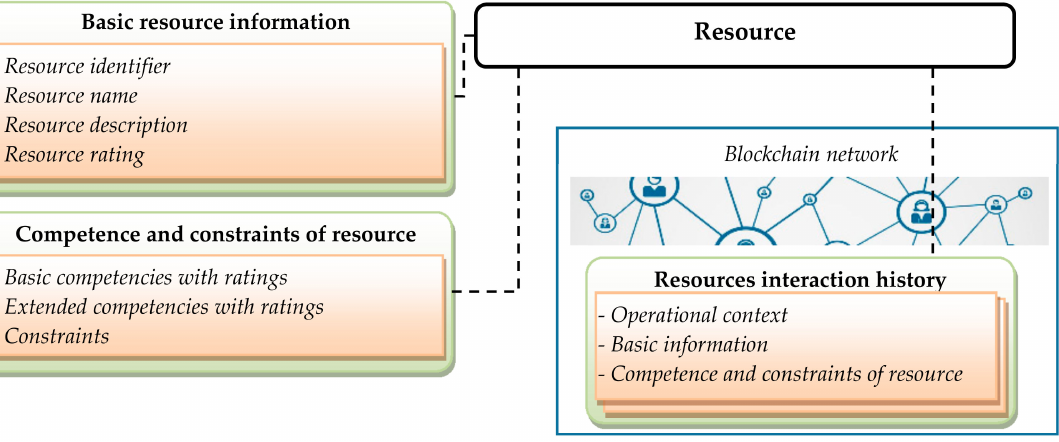
Figure 3. Resource Profile